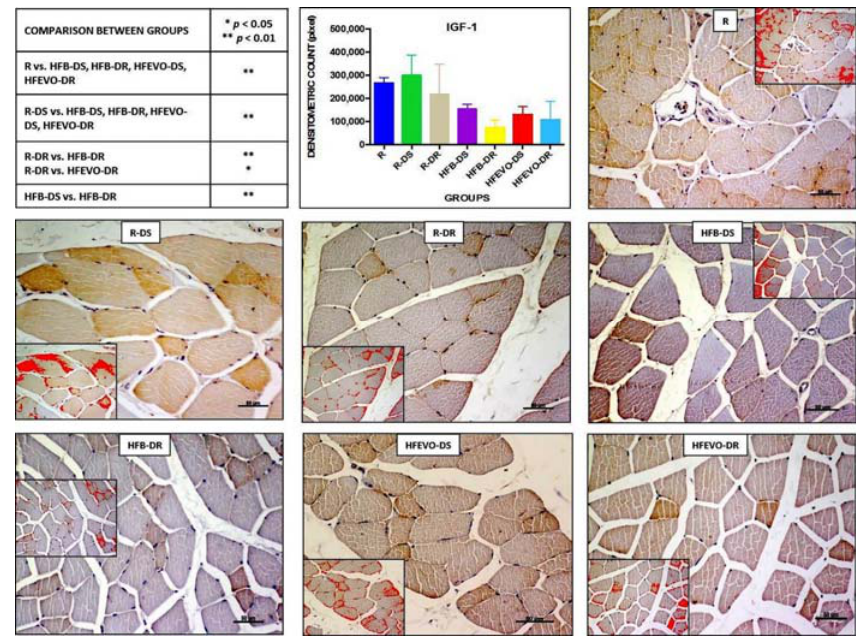
Figure 4. IGF ‐ 1 immunostaining, image analysis by software in which the red color represents the immunolabelling (inserts), and a graph representing the intensity of immunostaining (densitometric count pixel2) with statistical analysis ( p ‐ values in the table). For details, see the text. The data are presented as mean ± SD. Scale bars: 50 μ m.